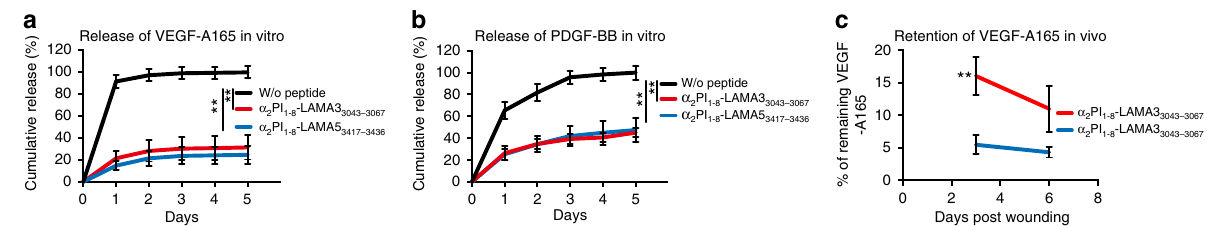
Fig. 7 GF retention in fi brin matrices is enhanced by incorporating laminin HBD peptide. a , b GF retention in the fi brin matrix. α 2 PI 1 – 8 -LAMA3 3043 – 3067 or α fi brin matrices were made in the presence of VEGF-A165 or PDGF-BB, and incubated in eight volumes of 2 PI 1 – 8 -LAMA5 3417 – 3436 peptide-functionalized physiological buffer for 5 days. The buffer was changed each day, and released GFs were quanti fi ed daily. The graphs show the cumulative release of a VEGF-A165 or b PDGF-BB over 5 days ( n = 4; mean ± SEM). All data points for laminin HBD peptides were statistically signi fi cant compared to controls without laminin HBD peptide ( p < 0.01, Mann – Whitney U test). c Fibrin matrices containing VEGF-A165 (200 ng/wound) with or without α 2 PI 1 – 8 - LAMA3 3043 – 3067 peptide were placed on the full-thickness back-skin wounds in 10 – 11-week-old C57BLKS/J-m/Lepr db (db/db) mice. After 3 and 6 days, retention of VEGF-A165 after 3 and 6 days in the fi brin matrix and the tissue surrounding the wound (2 mm beyond the wound margin) were quanti fi ed. Laminin HBD( + ) day 3: n = 10, other groups: n = 8, mean ± SEM. Mann – Whitney U test; ** p < 0.01. Two